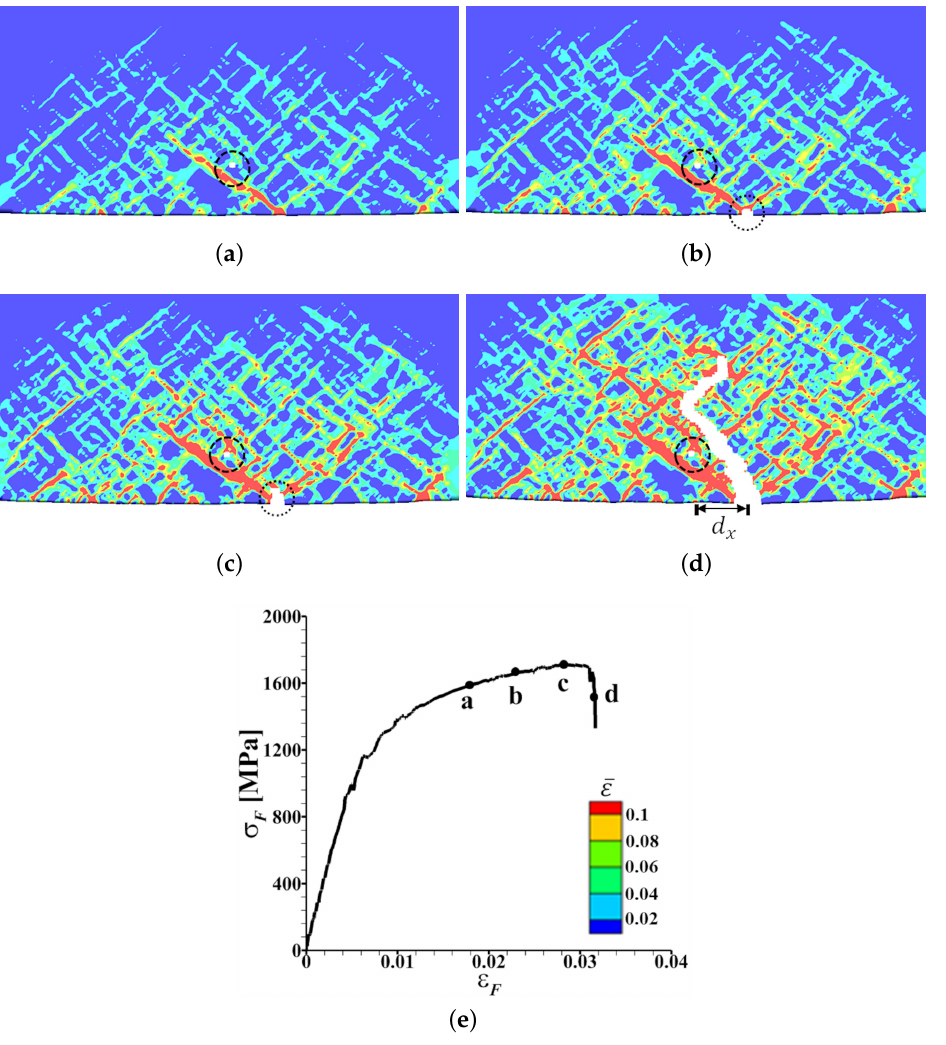
Figure 7. ( a – d ) The distribution of equivalent plastic strain, ¯ ε , in the near surface region on the tension side of a deformed 90 ◦ V-bend specimen with ‘discrete’ dual-phase microstructure and an inclusion of size, r I ≈ 1 e ( r I / r M ≈ 0.6), strength, ≈ 0.7) and location, dy / d = 0.125, at four macroscopic flexural strain, ε σ N = 300 MPa ( σ N / σ F 0 on the macroscopic flexural stress ( σ F )- ε F curve in ( e